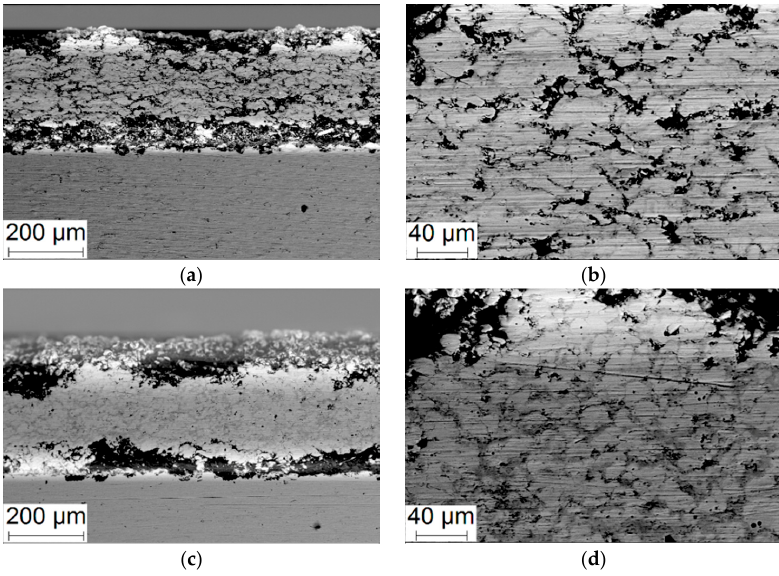
Figure 4. SEM-micrographs of the coating cross-section of specimens produced in regime No. 3 ( a , b ) and No. 4 ( c , d ).